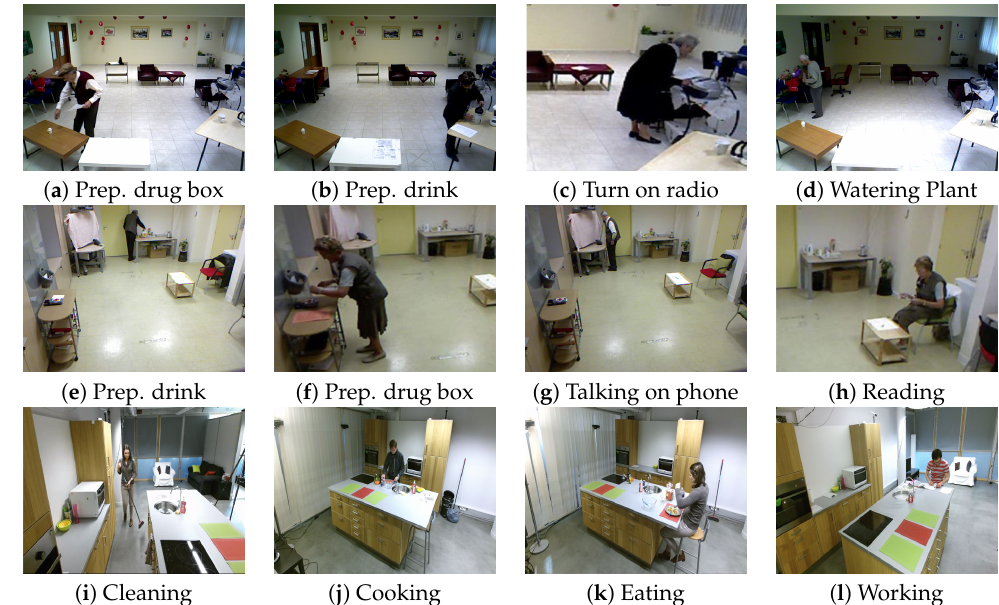
Figure 7. ( a – d ) Instances of daily activities provided in GAADRD; ( e – h ) CHU; and ( i – l ) DAHLIA